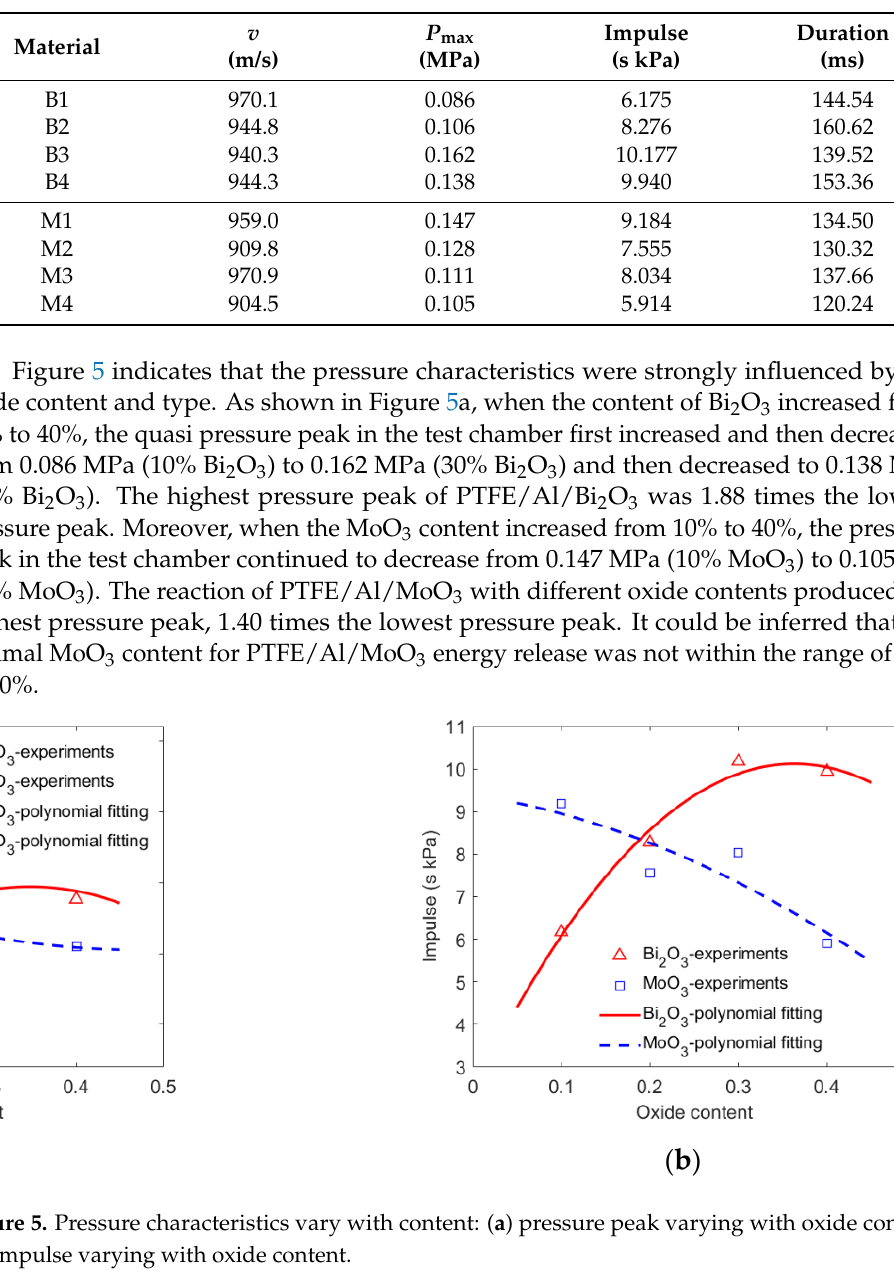
Table 3. The reaction pressure characteristics of PTFE/Al/oxide in test chamber.